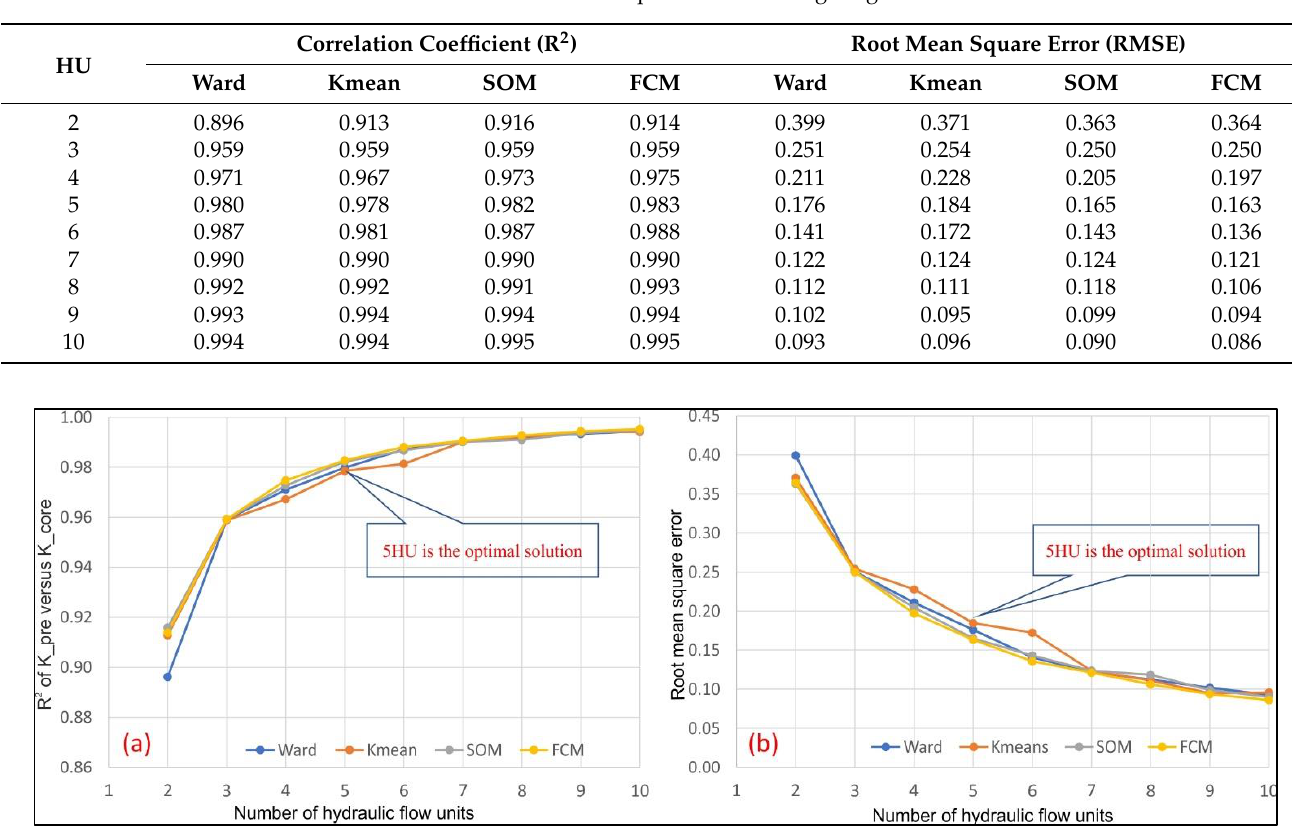
Figure 6. Determination of the optimal number of HU groups by comparing machine learning clustering methods based on ( a ) the correlation coefficient (R 2 ) of (K_pre versus K_core) and ( b ) the number of HU groups. Figure 6 answers the question “How many hydraulic flow units do we need?”. In this case study, we can see clearly that 5 HU is the optimal solution for clustering of HU; the FCM method for highest R 2 = 0.983, and RMSE for lowest RMSE = 0.163. These results